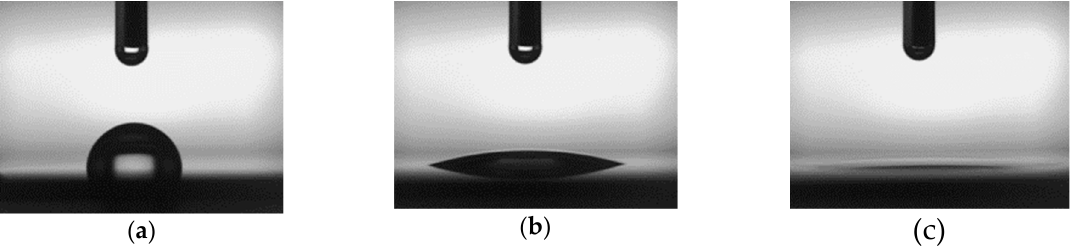
Figure 2. Measured contact angle vs. plasma treatment time.